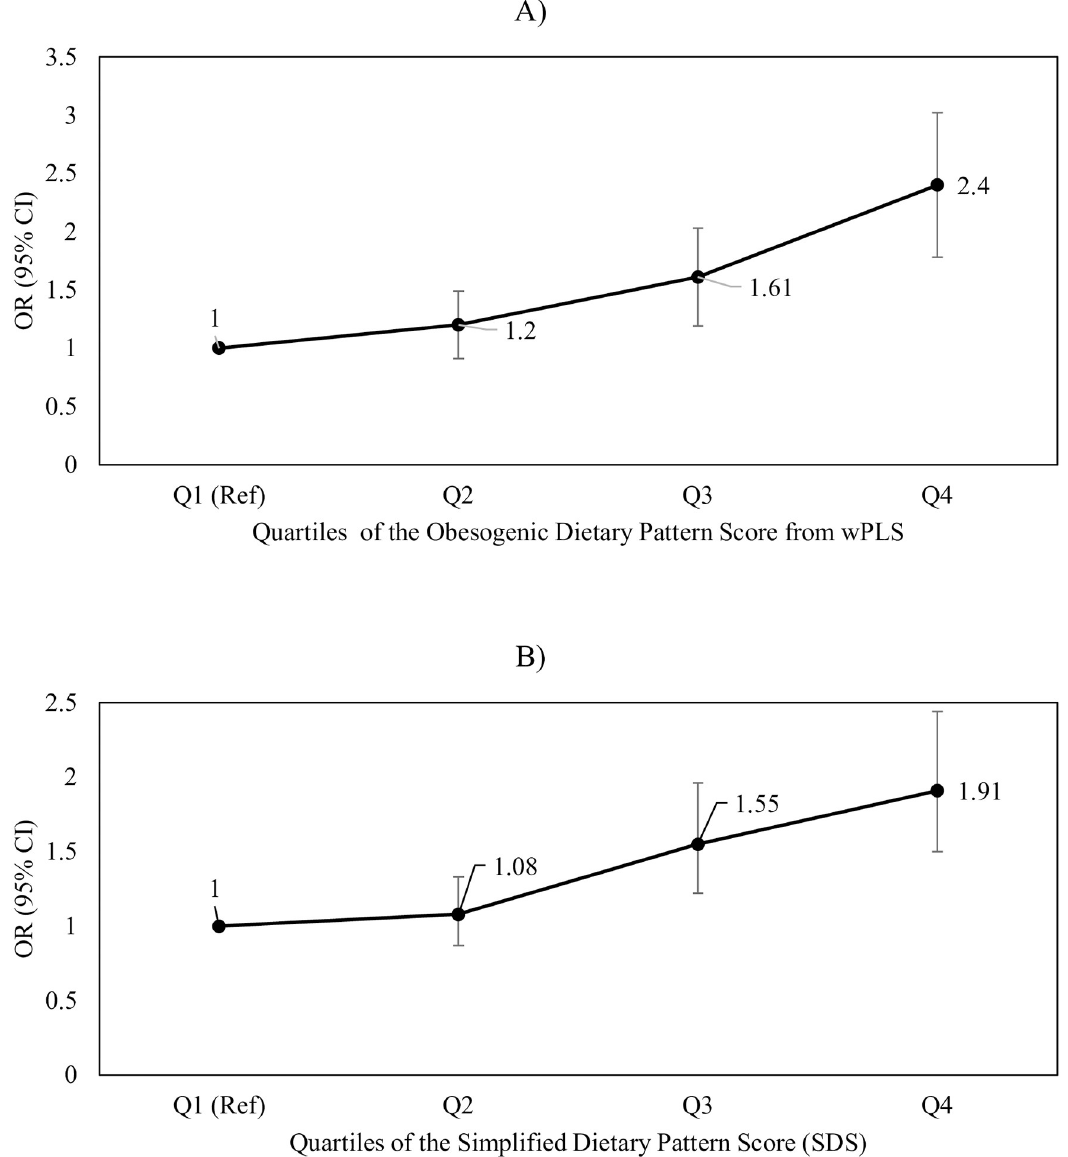
Fig 2. Multivariate-adjusted odds ratios (ORs) and 95% confidence intervals (CIs) for the likelihood of being obese (BMI � 30) across quartile categories of A) simplified dietary pattern score (SDS) and B) the energy-dense, high-fat and low-fiber density (“obesogenic”) dietary pattern score from the wPLS (weighted partial least squares) model among Canadian adults from CCHS-Nutrition 2015 ( n = 12,049). Q1 (“Healthiest”) was used as reference. Both P-trends are < 0.0001. Both models were adjusted for age, sex, physical activity, smoking status and energy misreporting